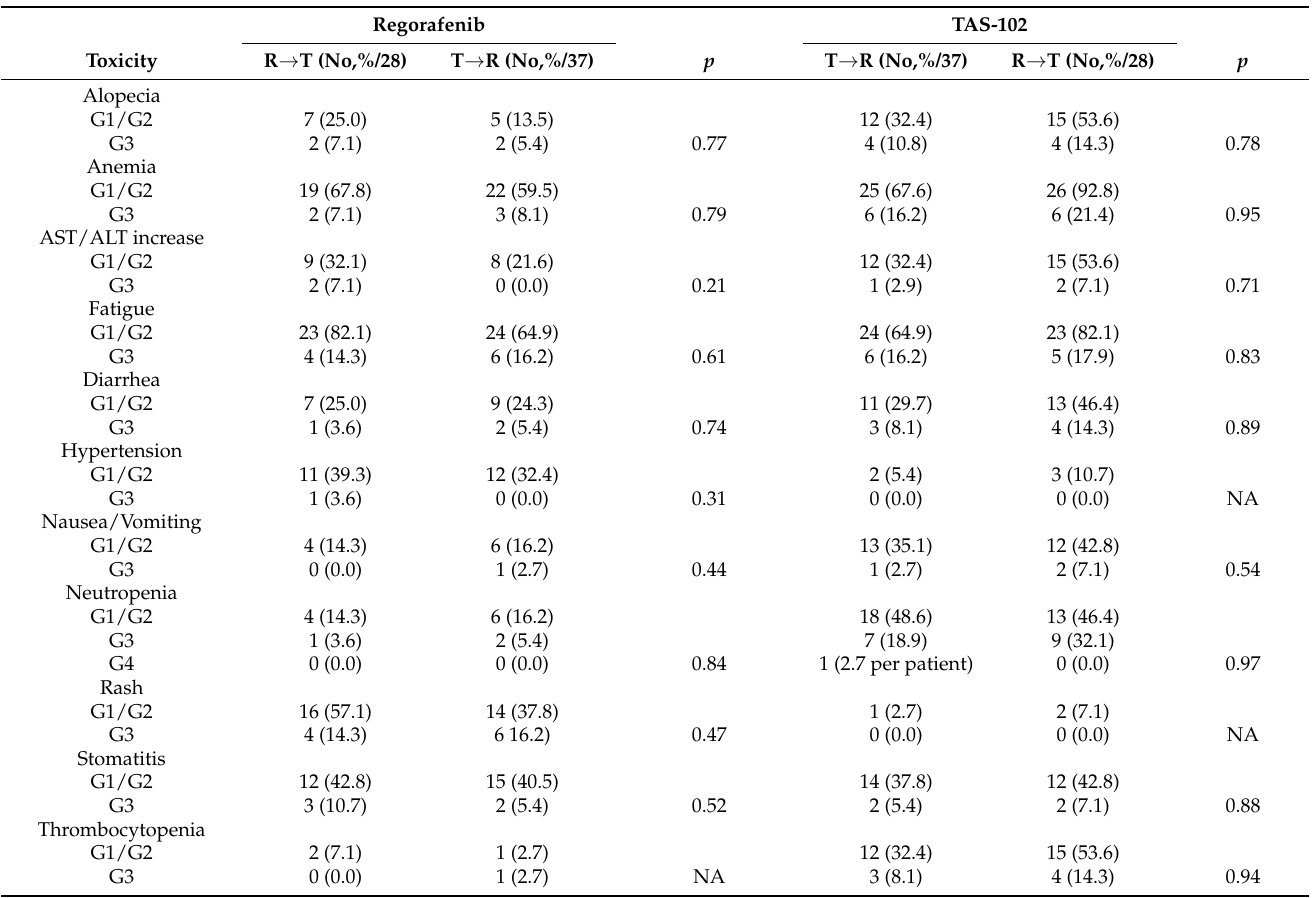
Table 2. Hematologic and non-hematologic toxic events per patient.